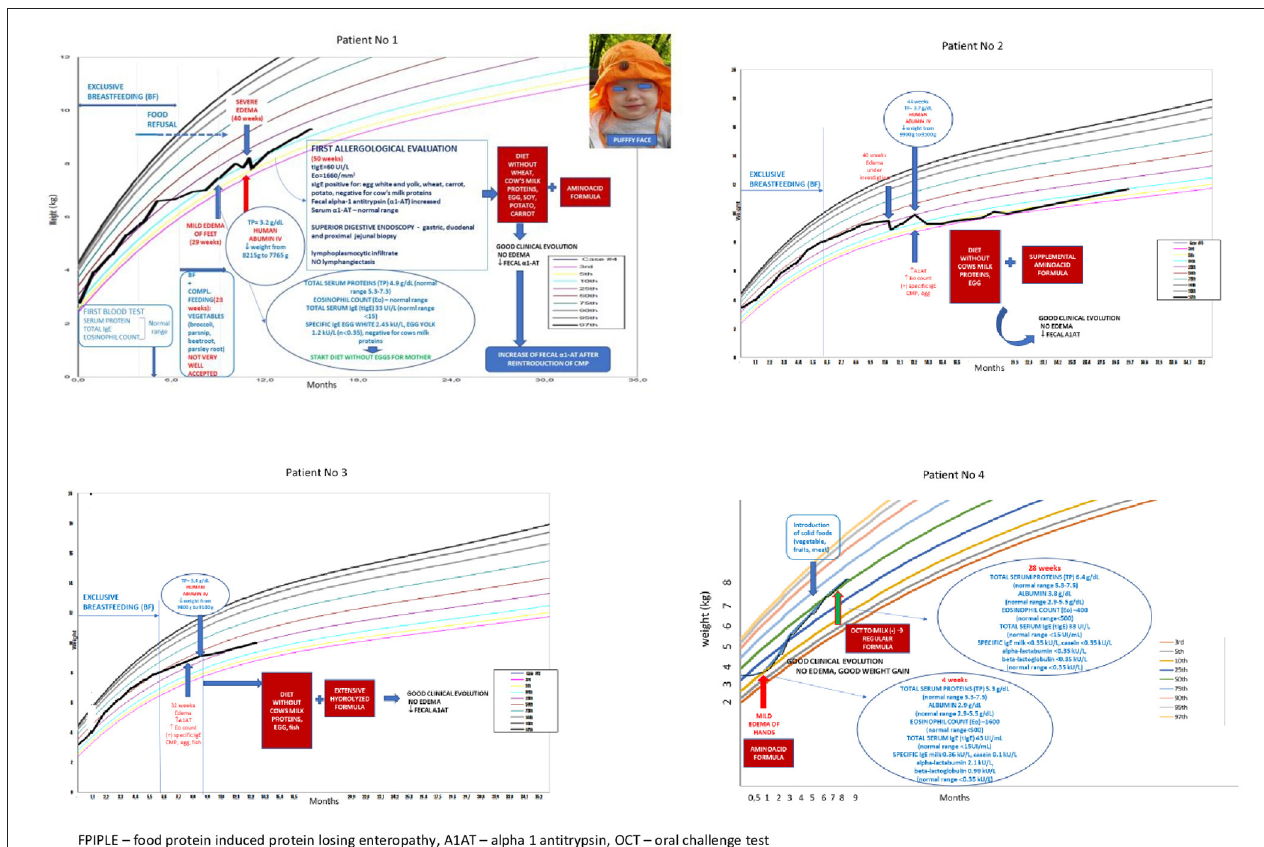
FIGURE 1 | The weight charts of 4 patients with FPIPLE. OCT = oral challenge test, TP = total protein, α 1-AT= fecal alpha-1 antitrypsin. FPIPLE, food-protein induced protein-losing enteropathy; A1AT, alpha 1 antitrypsin; OCT, oral challenge